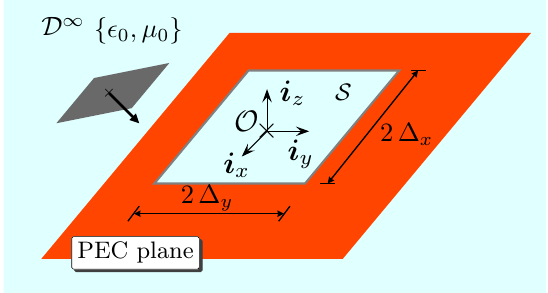
Figure 1. Rectangular aperture in a PEC